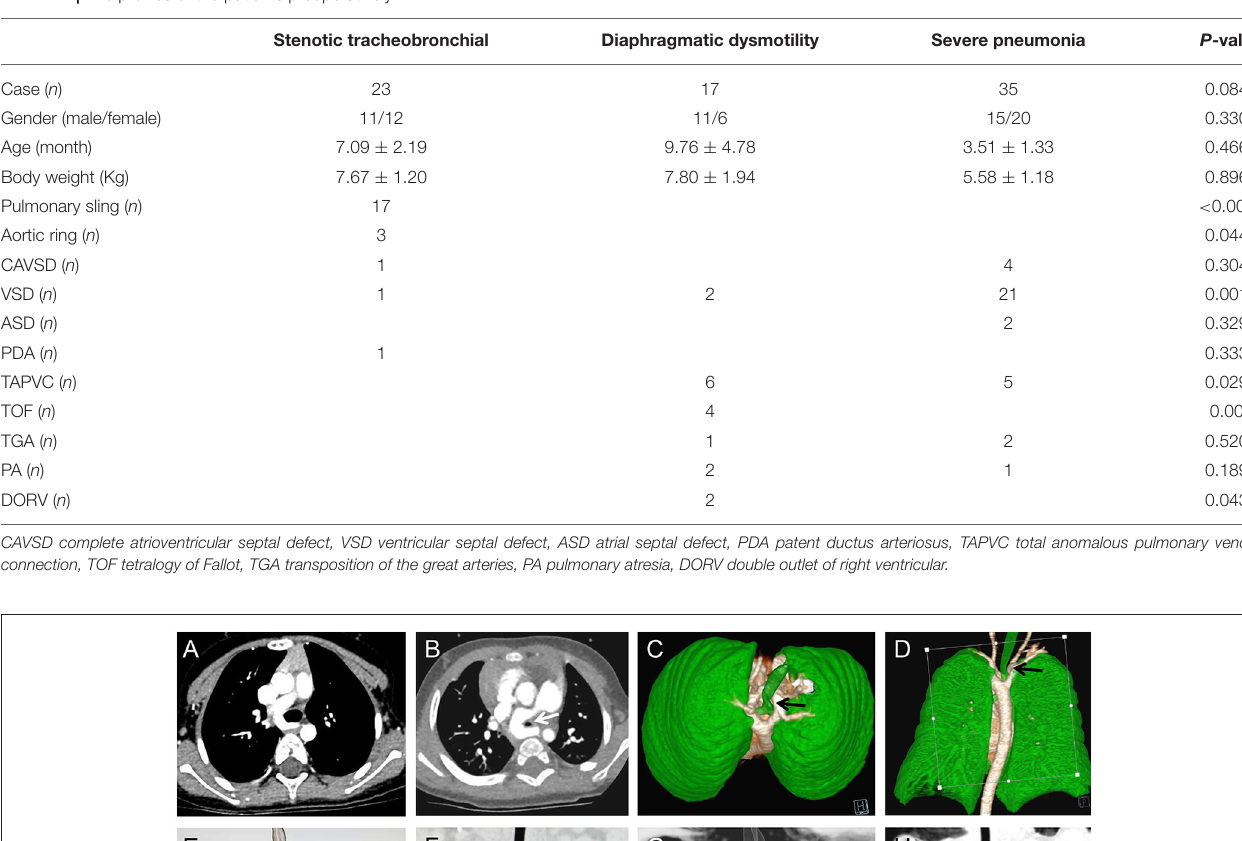
TABLE 1 | The profiles of the patients preoperatively.